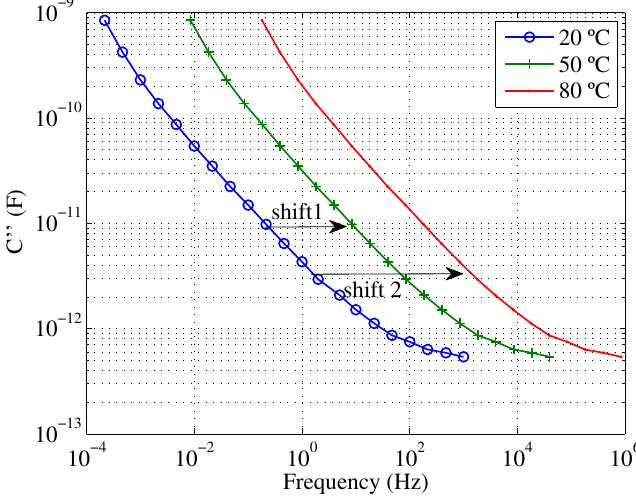
Figure 7. Dielectric losses of the sample with moisture 1.8% measured at 20 ◦ C and calculated for temperatures 50 ◦ C and 80 ◦ C (Shift 1 = − 1.5976, Shift 2 = −